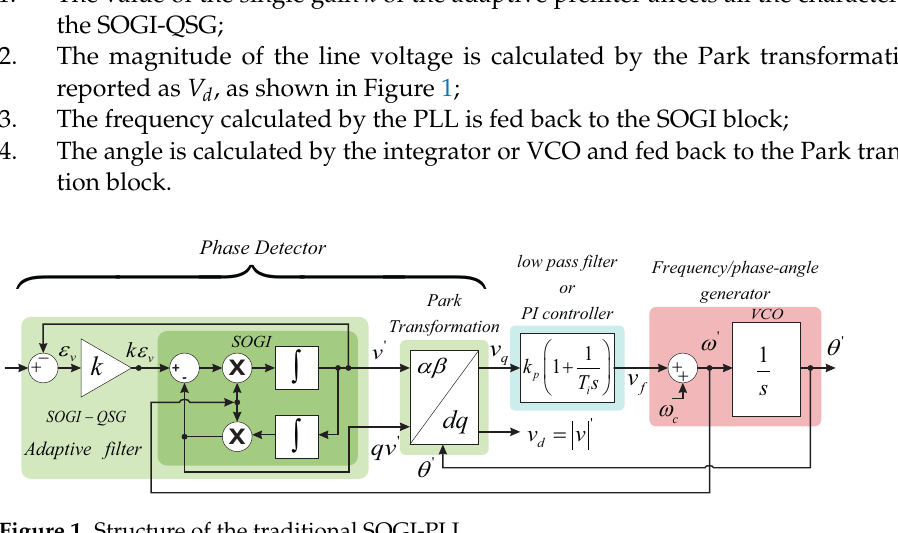
Figure 1. Structure of the traditional